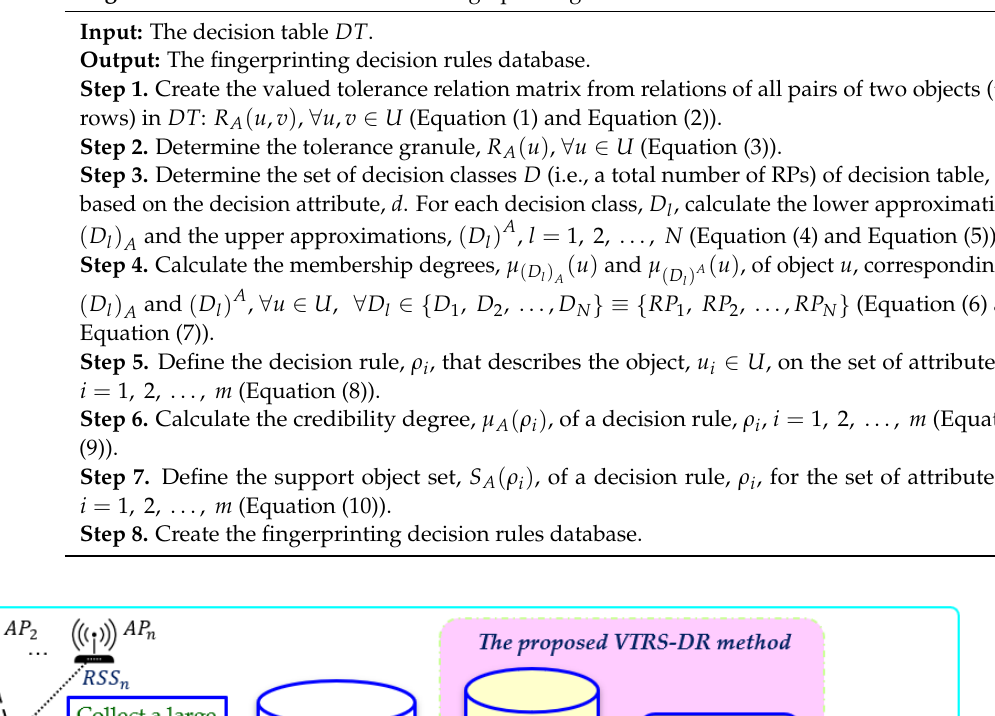
Algorithm 1: The Construction of a Fingerprinting Decision Rules Database for IPS